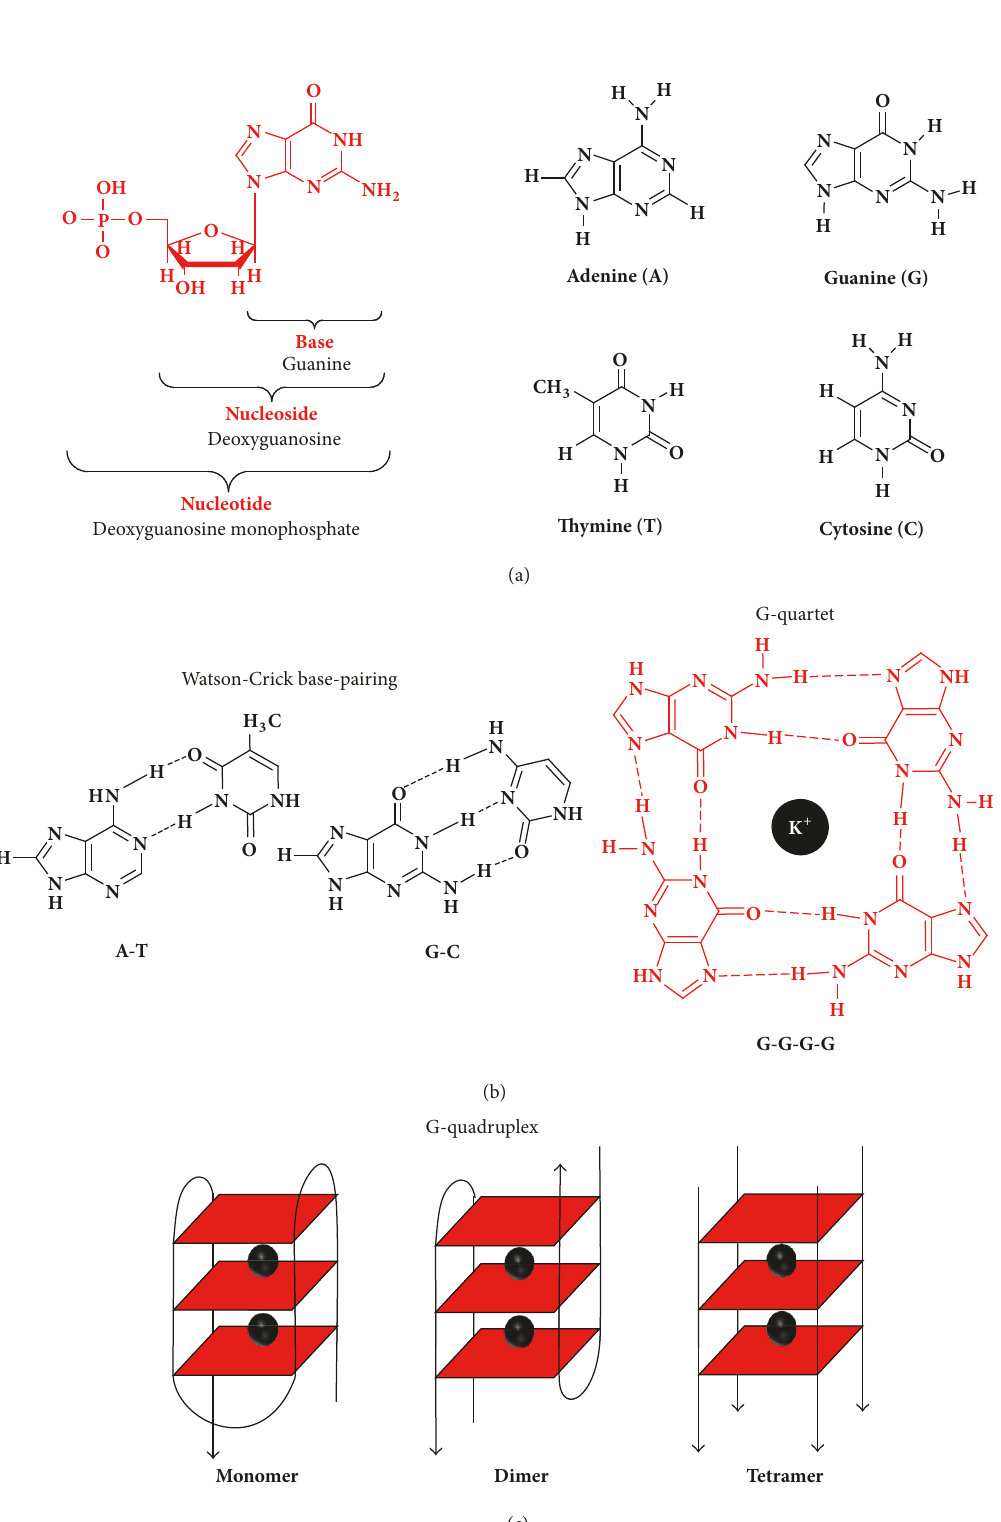
Scheme 2: (a) Chemical structure of DNA nucleotides, nucleosides, and bases, (b) Watson-Crick base-pairing and G-quartet, and (c) G-quadruplex configurations. [Adapted from [11, 13] with